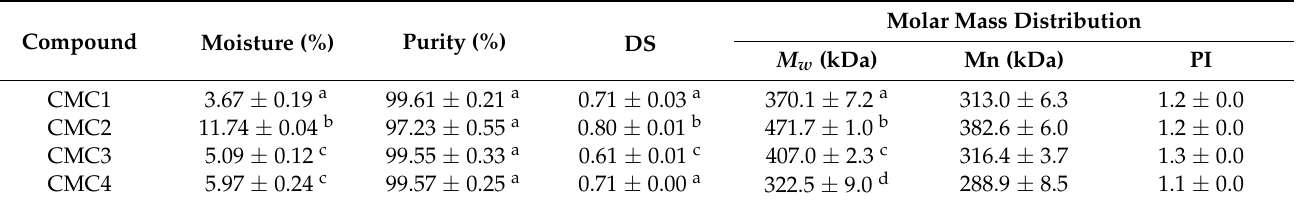
Table 1. T Physical characteristics of the commercial CMCs evaluated. Different letters represent the statistically significant ( p < 0.05) differences found between